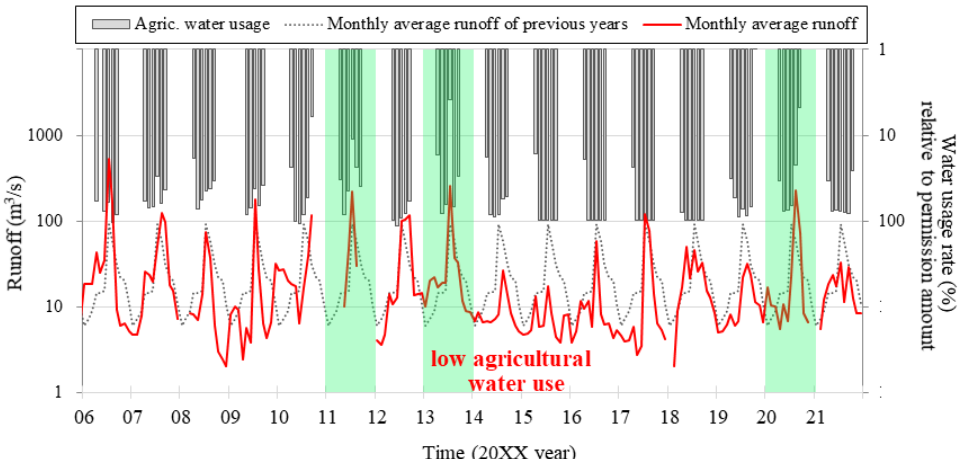
Figure 4. Time series of monthly runoff rate and agricultural water usage rate on Seom River basin for last 15 years; red line indicates monthly average runoff, dot-line indicates monthly average runoff of for previous 15 years, gray box indicates the usage percentage of agricultural water relative to permission amount.